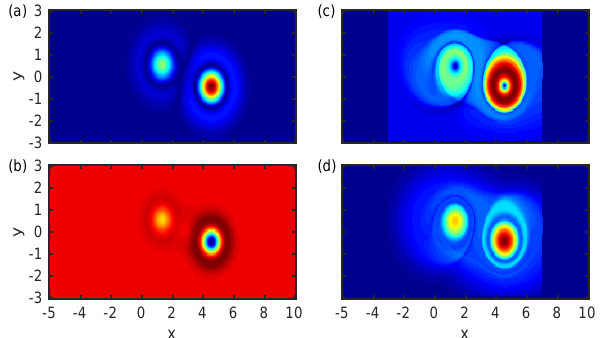
Figure 3. Modulus of vorticity (a) , Okubo–Weiss parameter (b) , Lagrangian descriptor M (c) and Lagrangian descriptor M V (d) for the hydrodynamic model of a vortex street at t = 0.151 with τ = 0.15, normalized to the maximum value. Blue colours indicate small values, and red large values of the depicted quantity. The dark blue regions in (c) and (d) are regions where the trajectories have left the region of